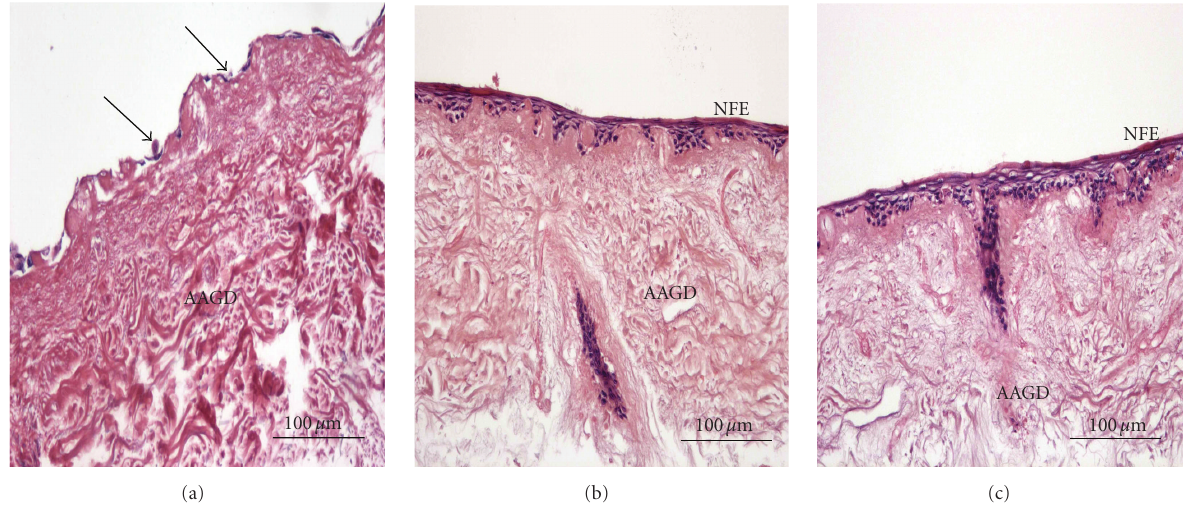
Figure 7: Histomorphological analysis performed on the biosubstitute sections obtained from uncultured keratinocytes at (a) 7 days, (b) 14 days, (c) 21 days post nebulization. Arrows indicate the foci and/or scattered keratinocytes. Original magnification: 10x. AAGD: alloplastic acellular glycerolized dermis; NFE: newly formed